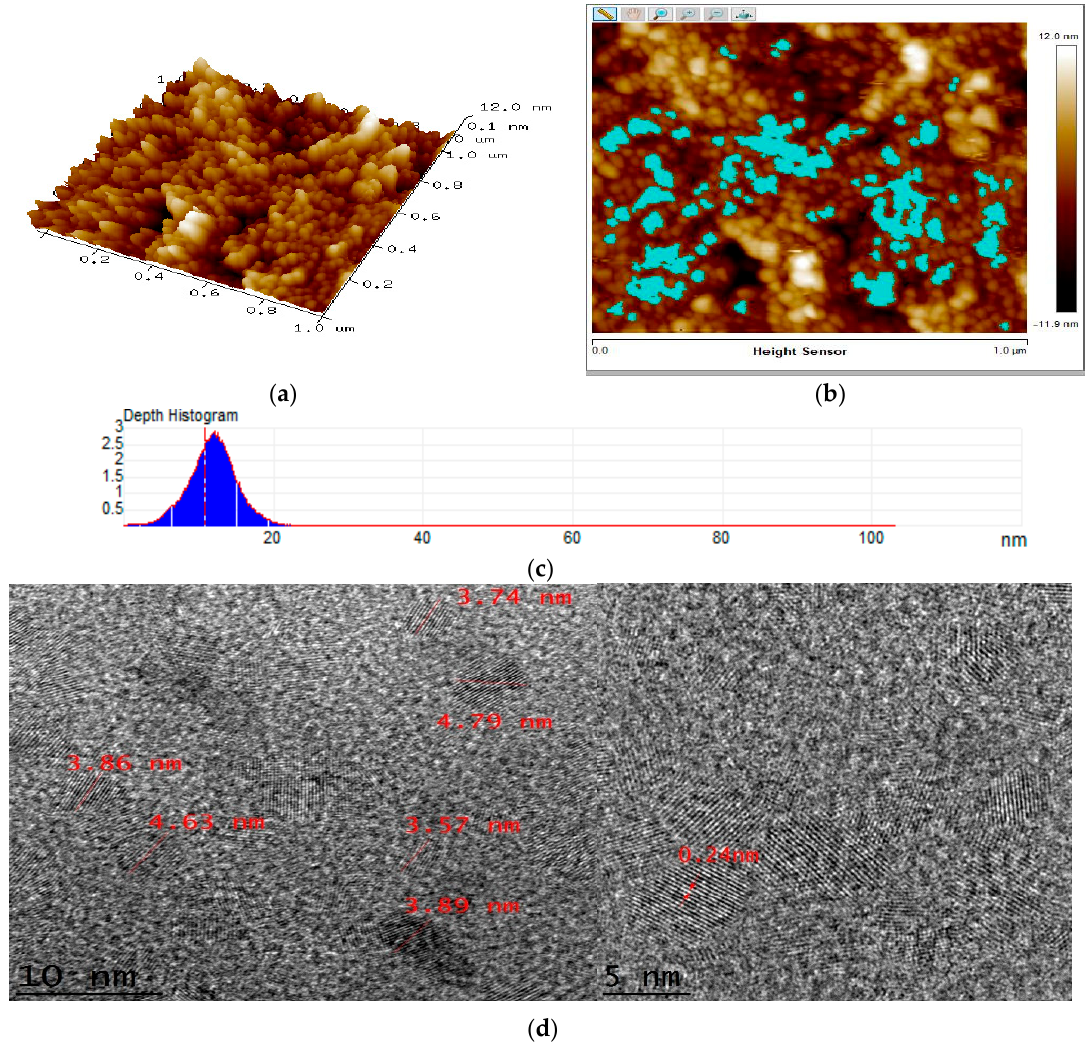
Figure 7. Atomic force microscopy (AFM) and high resolution transmission electron microscopy (HrTEM) of carbon dots (CDs). ( a ) 3D CDs particles, ( b ) 2D CDs particles, ( c ) CDs particle distribution, and ( d ) CDs particle sizes and lattice space.